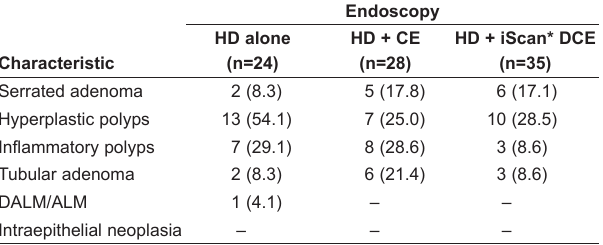
TAbLe 2 baseline characteristics of colonic lesions in inflammatory bowel disease patients